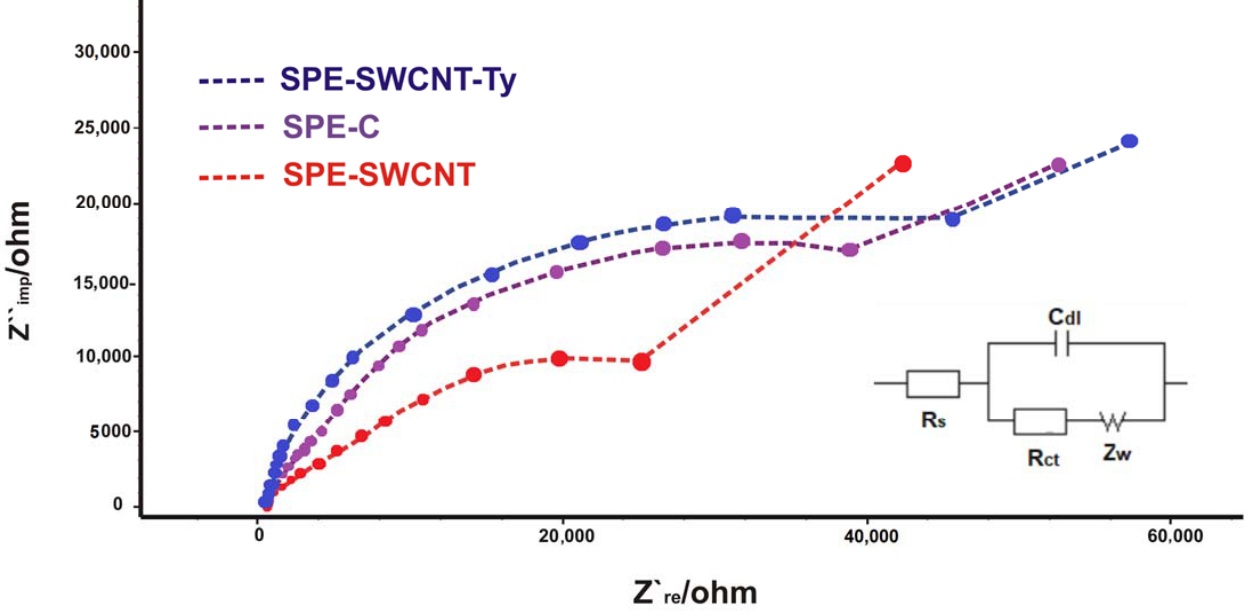
Figure 3. Nyquist plots of EIS for SPE-SWCNT (red line), SPE-C (purple line), SPE-SWCNT-Ty (blue line) in 10 − 1 M KCl and 10 − 3 M [Fe(CN) 6 ] 3 − /4 − for a frequency range of 0.01 Hz to 10 kHz, amplitude 10 mV. Inset: Equivalent circuit applied to fit the impedance spectra.